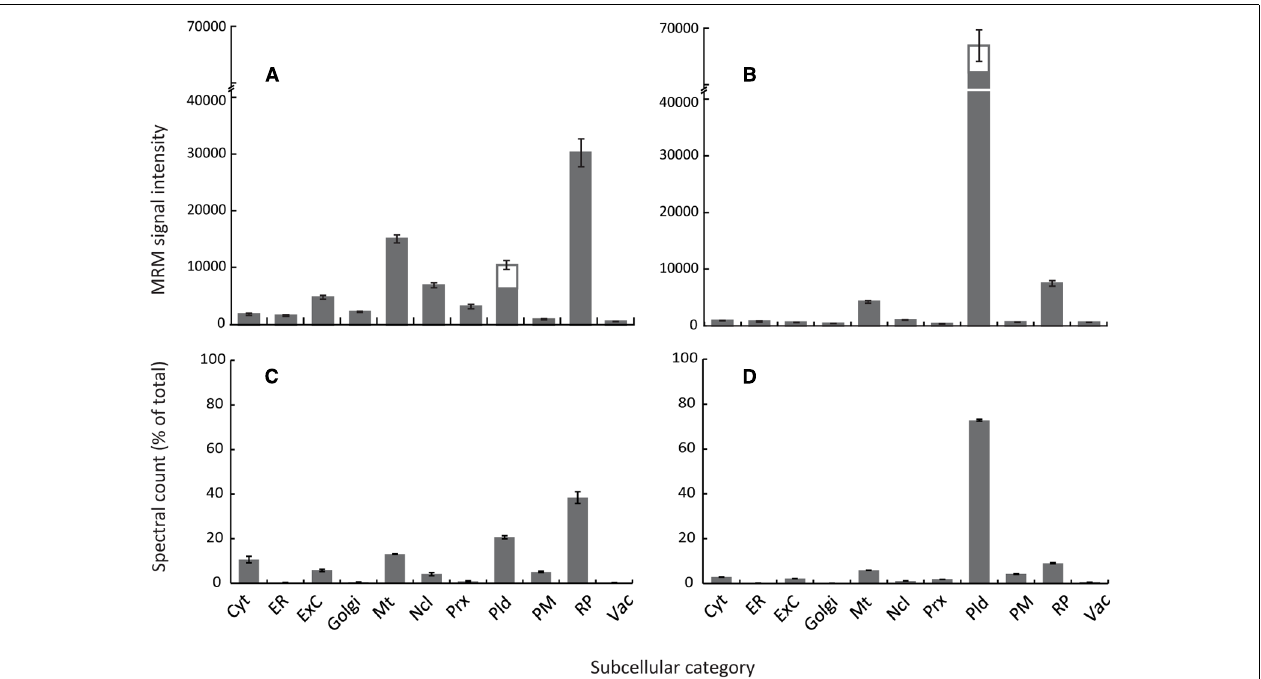
FIGURE 1 | Arabidopsis organelle profiling by MRM and shotgun proteomics. Estimation of relative abundance of cellular compartments from total protein extracts of 7-day old cell suspension cultures (A,C) or 4-week rosettes (B,D) . MRM assays (A,B) were performed using two to five marker proteins per compartment, except the plastid where six marker proteins were used, including both the light-harvesting complex candidates (three proteins) and non-light harvesting complex candidates (three proteins). Error bars show standard error for n = 3 biological replicates. Spectral counts (C,D) were